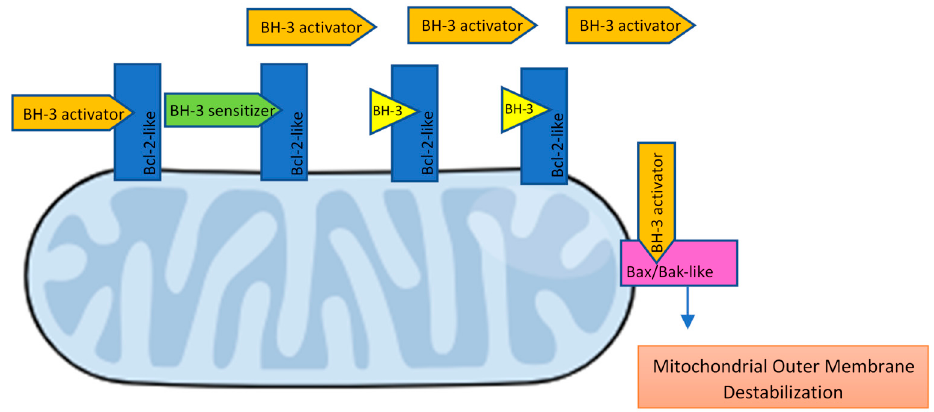
Figure 5. BH3-mimicking and apoptosis induction BH-3-mimicking peptides bind to anti-apoptotic Bcl-2-like proteins as competitive inhibitors, allowing BH-3-activators release and pro-apoptotic Bax/Bak-like proteins activation leading to cell death.